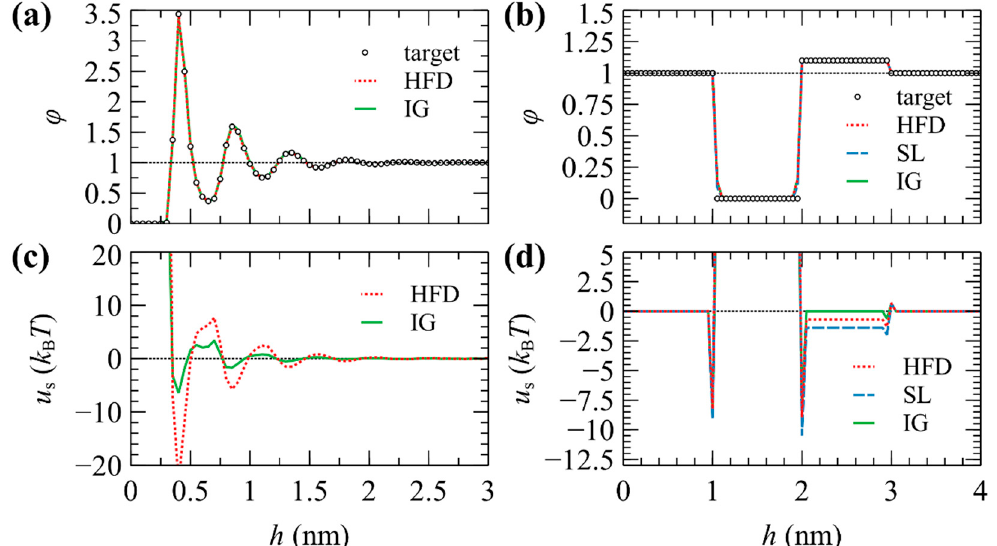
Figure 4. ( a , b ) Target (circles) and fitted density profiles from HFD (dots) and SL (dashes) EoS, and from an ideal gas of chains (solid lines). In ( a ), the target profile corresponds to a profile of C100 melt/graphite at 450 K from molecular dynamics [33]. In ( b ), the target profile equals ϕ = 0 for h ∈ [1, 2), ϕ = 1.1 for h ∈ [2, 3), and ϕ = 1 everywhere else. ( c , d ) The corresponding tabulated potentials, u s ( r ), for each case in ( a , b ). The horizontal dotted lines are guides to the eye.